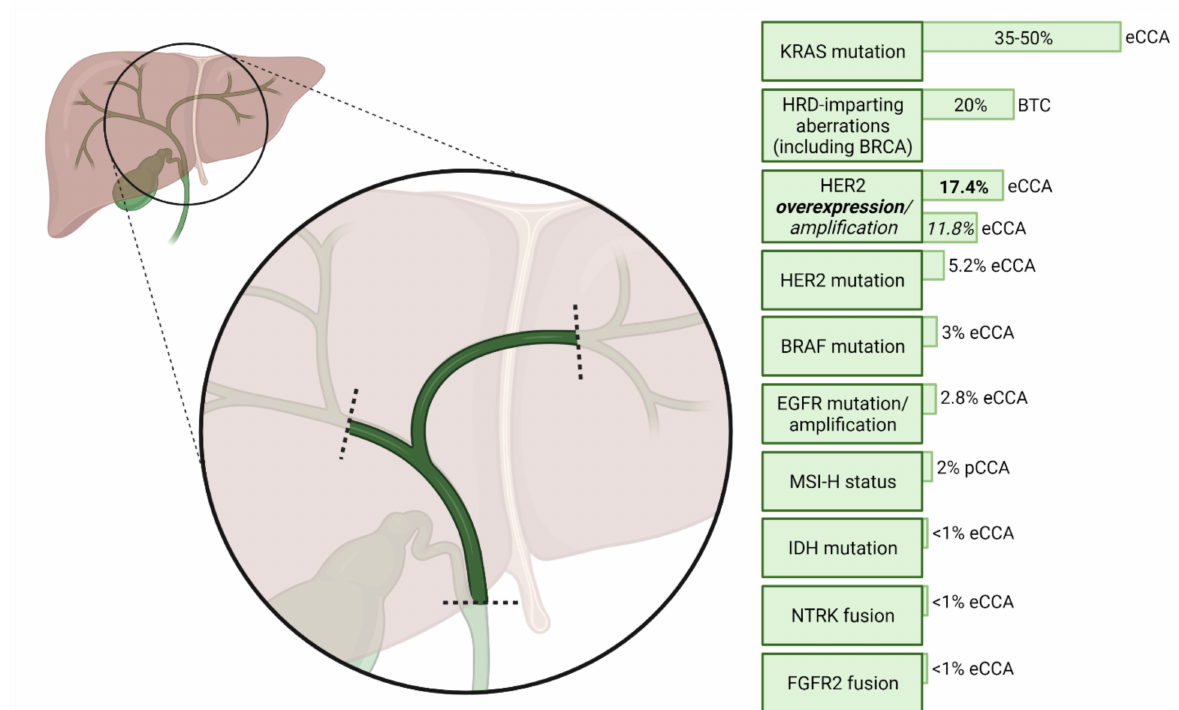
Figure 1. Frequency of potentially actionable molecular aberrations in perihilar cholangiocarcinoma. Anatomical groupings of patients sampled to determine each frequency are beside/below the corre- sponding frequency [25–36]. Rates of co-occurrence of the described molecular aberrations within patients are unknown. Created with BioRender.com. KRAS, Kirsten rat sarcoma virus. eCCA, extrahepatic cholangiocarcinoma. HRD, homologous repair deficiency. BRCA, breast cancer suscep- tibility gene. BTC, biliary tract cancer. HER2, human epidermal growth factor receptor 2. BRAF, v-Raf murine sarcoma viral oncogene homolog B. EGFR, epidermal growth factor receptor. MSI-H, microsatellite instability high. pCCA, perihilar cholangiocarcinoma. IDH, isocitrate dehydrogenase. NTRK, neurotrophic tropomyosin receptor kinases. FGFR2, fibroblast growth factor receptor